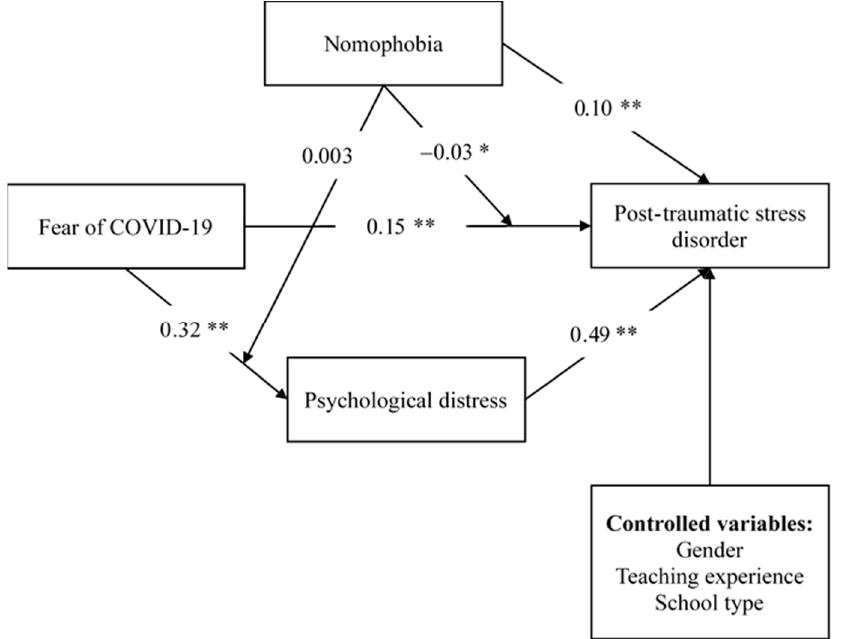
Figure 1. The moderated mediation model to explain post-traumatic stress disorder in Chinese teachers during COVID-19 pandemic. * p < 0.05; ** p < 0.00.